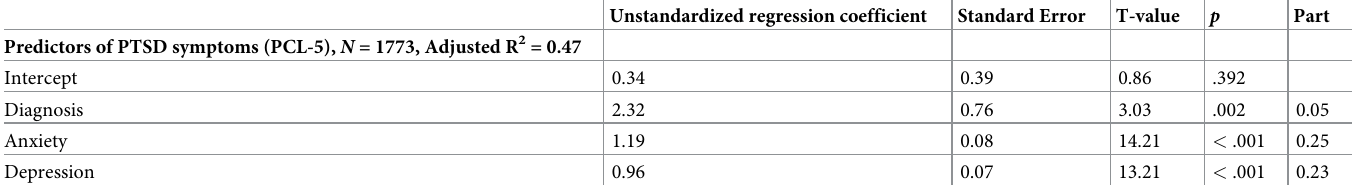
Table 4. Anxiety, depression, and diagnosis as predictor for PTSD symptoms.